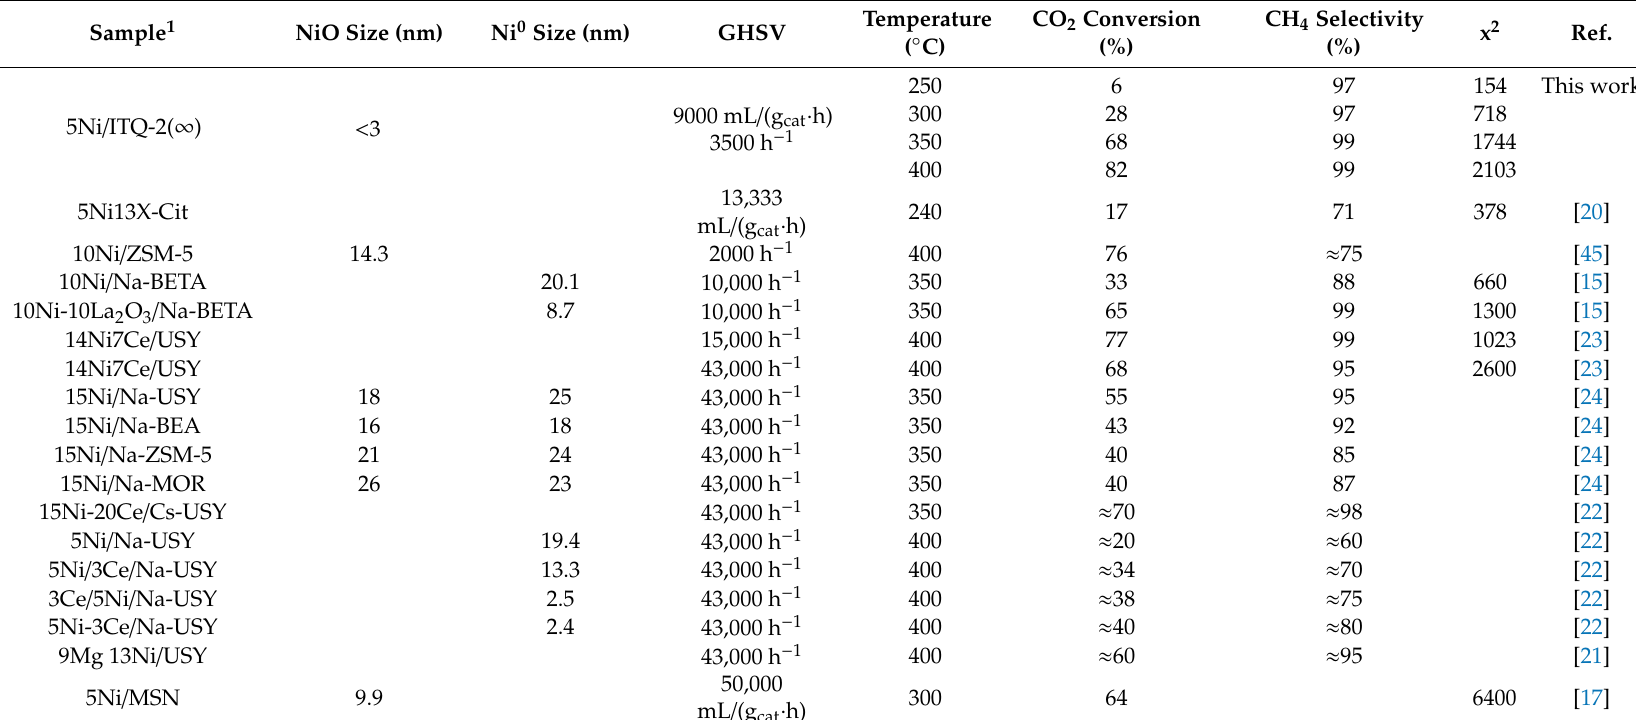
Table 3. Comparison of the catalytic results obtained using a 5Ni / ITQ-2( ∞ ) catalyst with those reported in the